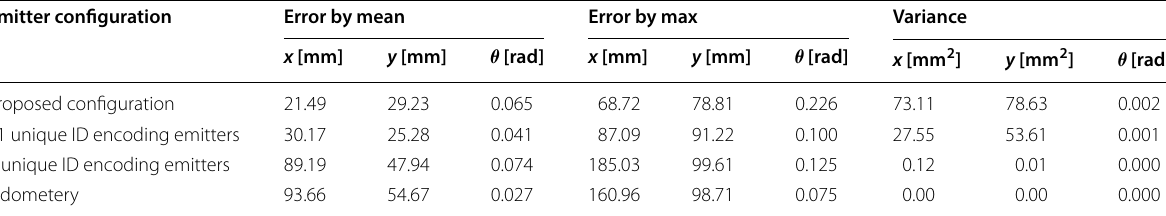
Table 2 Self‑localization errors at each of the 70 positions Emitter configuration